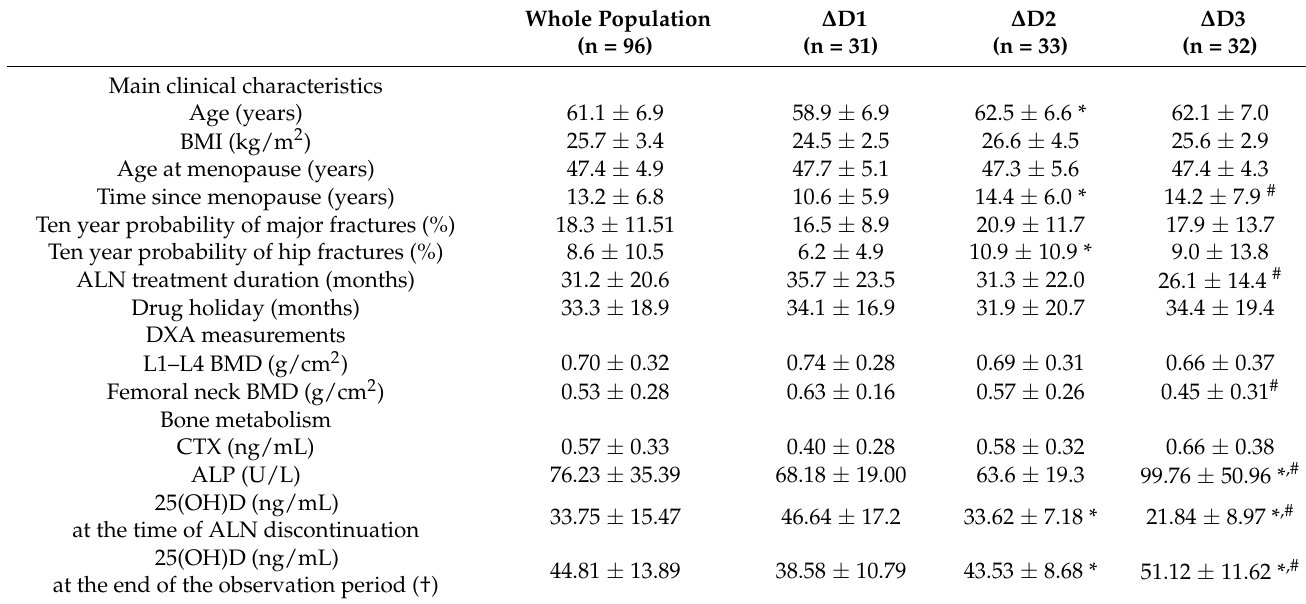
Table 1. Main clinical characteristics of postmenopausal women discontinuing alendronate treatment according with change of vitamin D